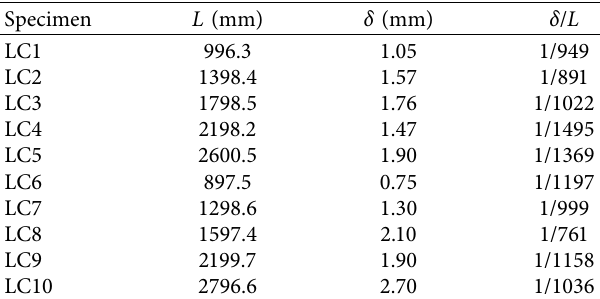
Table 2: Geometric initial imperfection along the weak axis